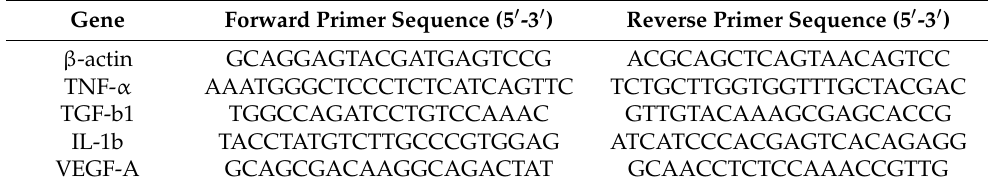
Table 1. PCR primers used in this study.